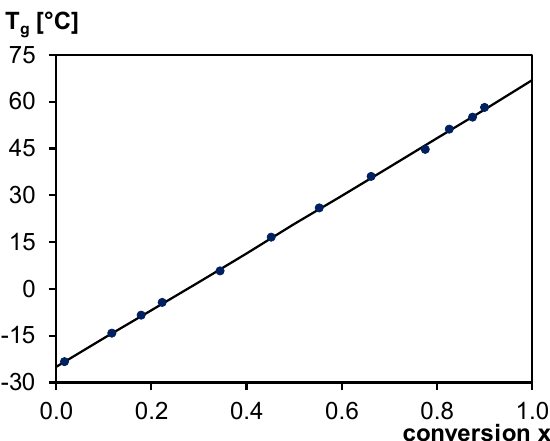
Figure 6. T g – x relation for 3M ‐ 3F630. Black line : DiBenedetto model with optimized T g0 , T g1 and λ ; Blue dots : experimental T g ‐ calculated x couples.